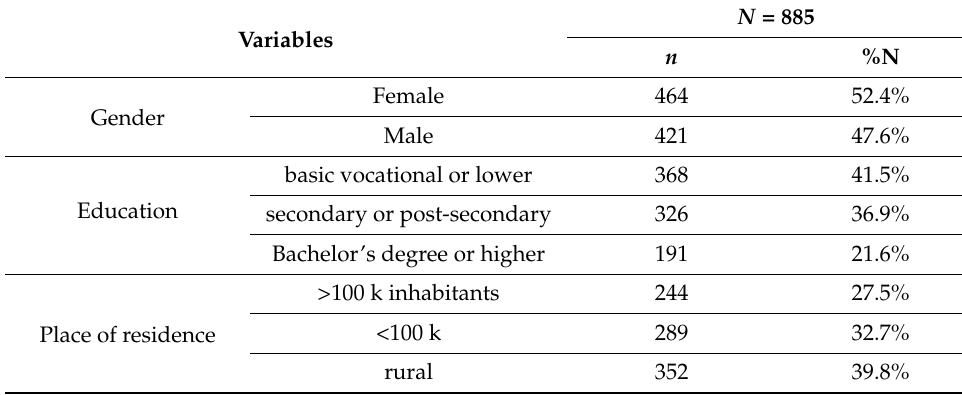
Table 2. Characteristics of the study